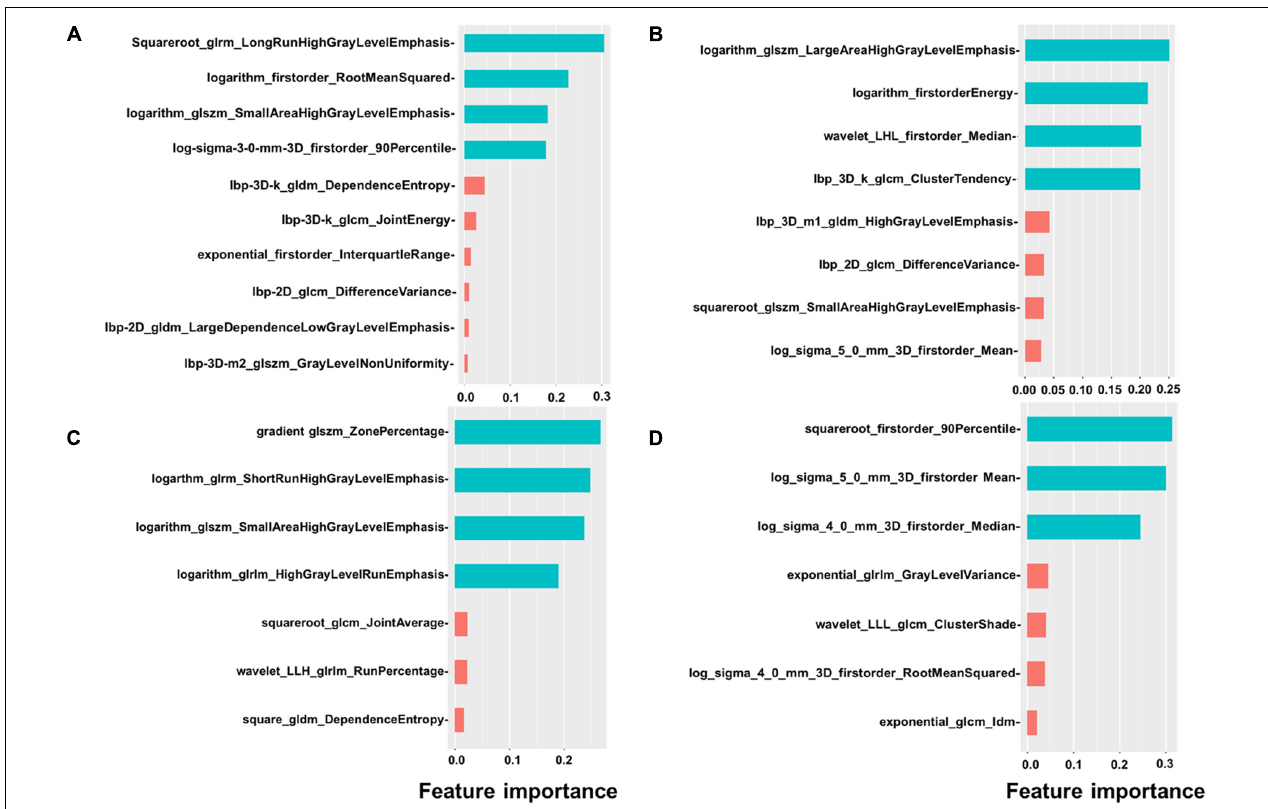
FIGURE 2 | Feature importance of radiomics. The figure shows the feature importance of global (A) , basal (B) , mid (C) , and apical (D) radiomics signature. Different colors represent different clusters.